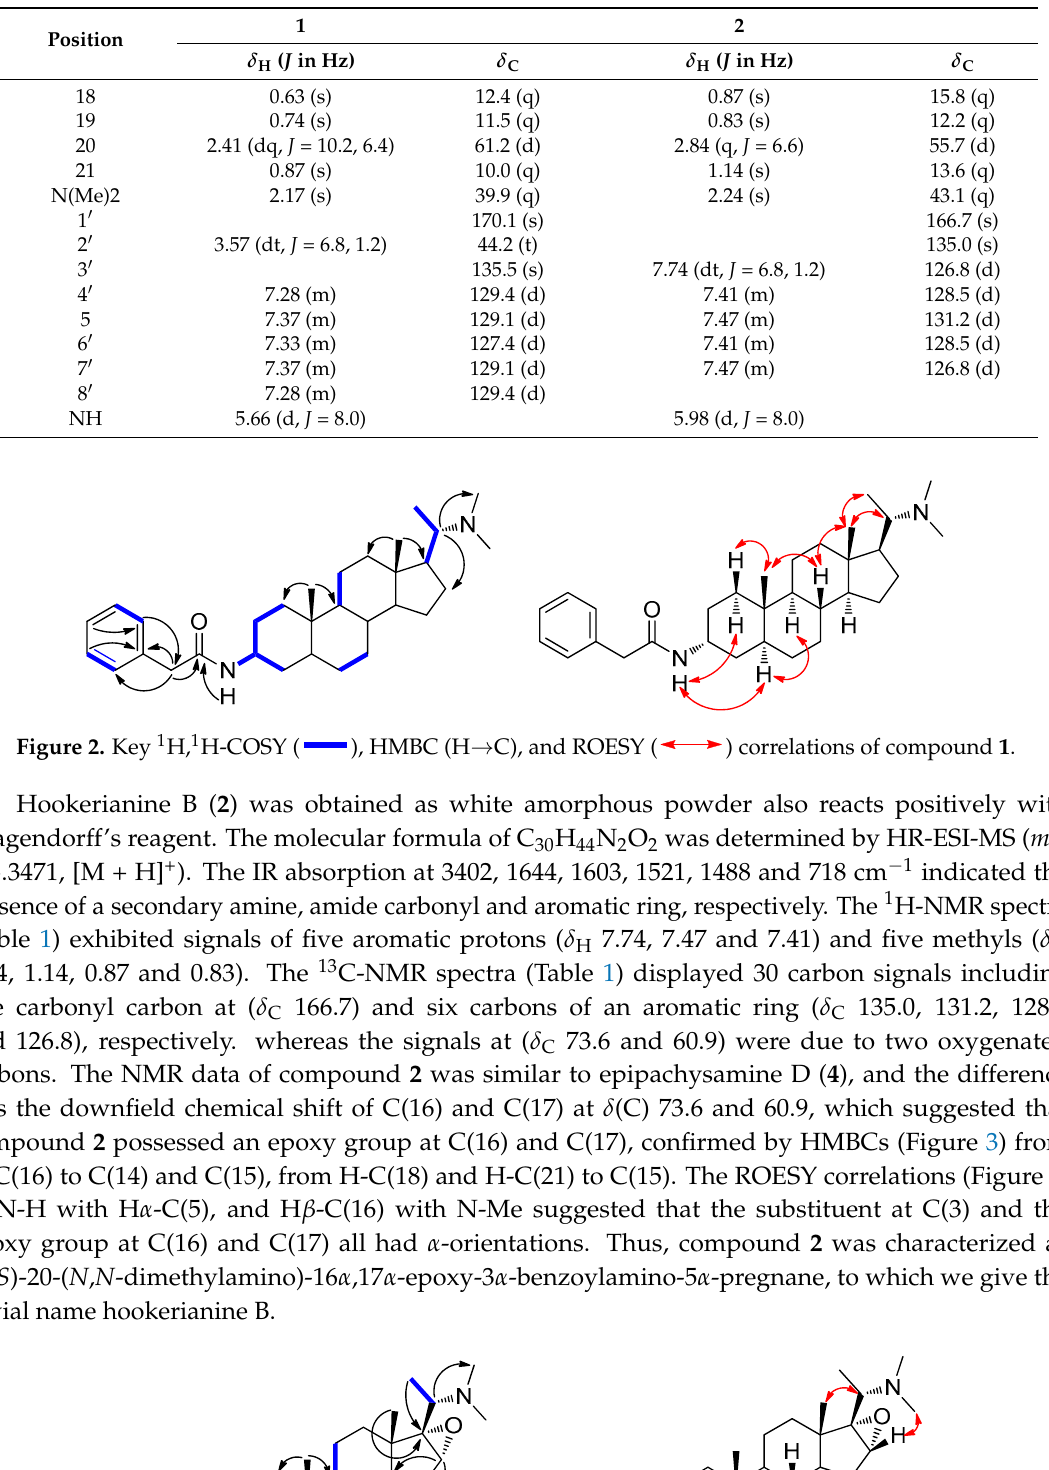
Figure 1. Structures of compounds 1 – 4 .